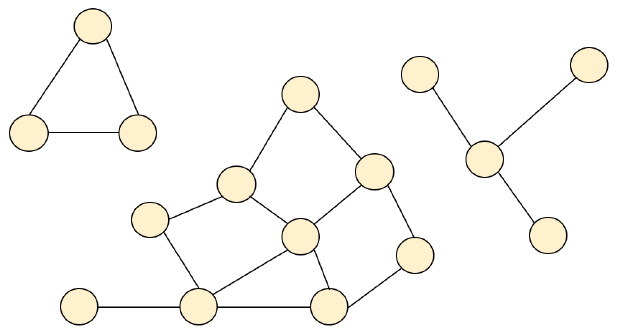
Figure 3. An example of 3 connected components within an idealized network.